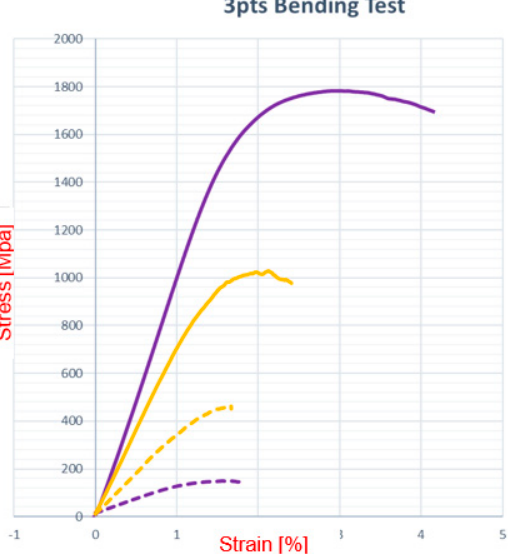
Figure 2. Diagram of three-point flexural strength on four different types of specimens.